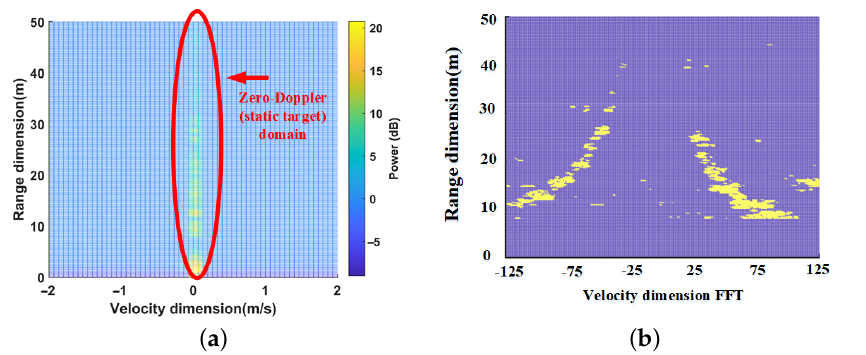
Figure 11. Static target distribution in the RDM and RAM. ( a ) RDM in a two-dimensional view. ( b ) RAM in a two-dimensional